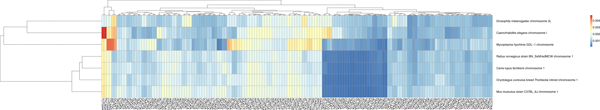
The AATTCG-spectrum set. We note that mouse and rat are not closely related. The bacterium is also evolutionarily located between the mammals and the subtree containing the worm and fruit fly.